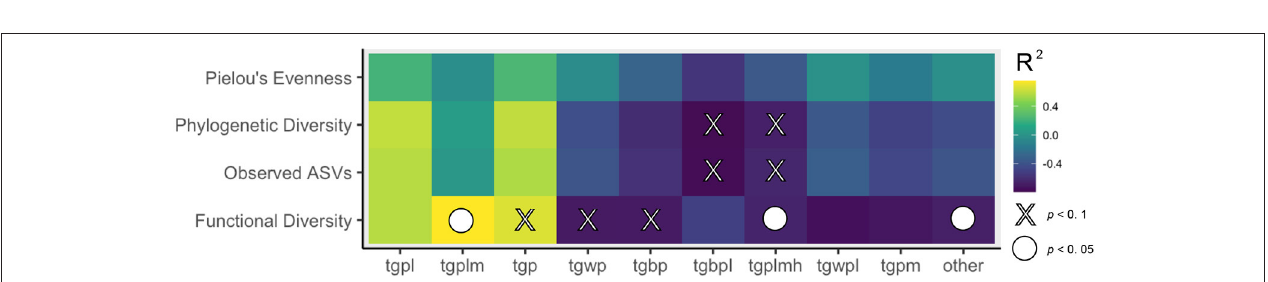
FIGURE 6 | (A) Relative abundances of sources identified in samples separated by air type on the bottom (outdoor route 1 vs. outdoor route 2 vs. indoor transit) with collection date above each column. Hypothesis test results and factors are under the legend. (B) Relative abundances of potentially pathogenic taxa identified in samples separated by air type on the bottom (outdoor route 1 vs. outdoor route 2 vs. indoor transit) with collection date above each column. Taxa in abundance smaller than 0.01% were grouped in the category “other” for visualization only. Hypothesis test results and factors are under the legend.